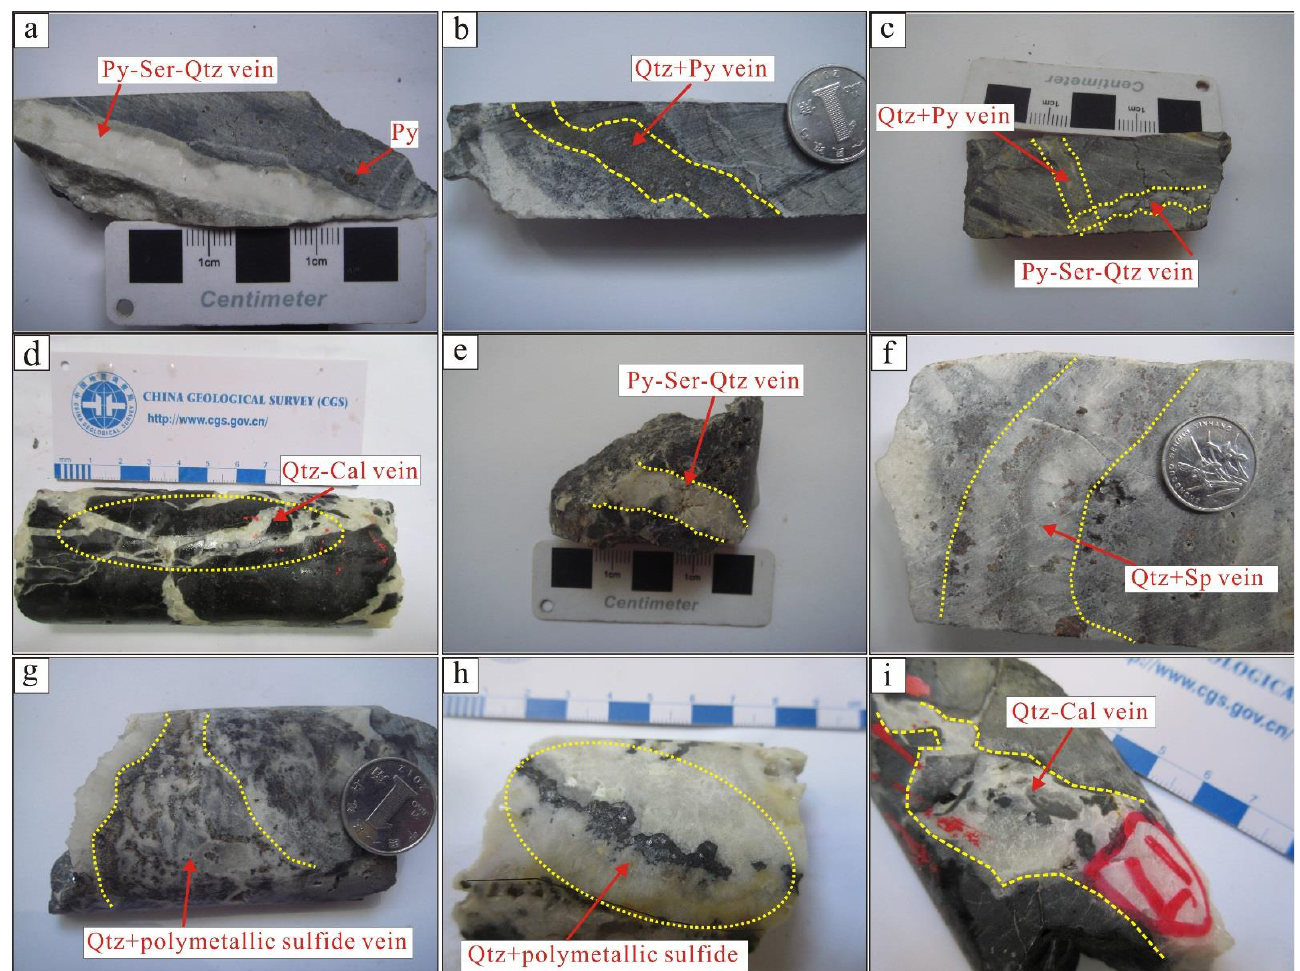
Figure 4. Photographs of different stages in the Changkeng – Fuwan Au ( a – d )-Ag ( e – i ) deposit. ( a ) Pyrite – sericite – quartz in the early stage; ( b ) pyrite – quartz vein in the middle stage; ( c ) early stage pyrite – sericite – quartz vein cut by middle-stage quartz – pyrite vein; ( d ) quartz – carbonate vein in the late stage; ( e ) pyrite – sericite – quartz in the early stage; ( f ) quartz and sphalerite in the middle stage; ( g , h ) quartz – polymetallic sulfide vein in the middle stage; and ( i ) quartz – carbonate vein in the late stage. Py, pyrite; Sp, sphalerite; Qtz, quartz; Ser, sericite; and Cal, calcite.